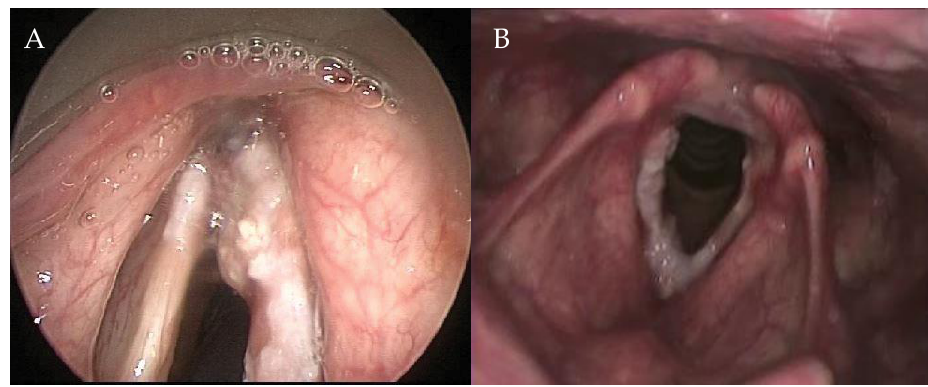
Figure 1. Extension in the anterior commissure. ( A ) Fiber endoscopic view during outpatient examination; ( B ) Endoscopic examination of the same patient in anesthesia.